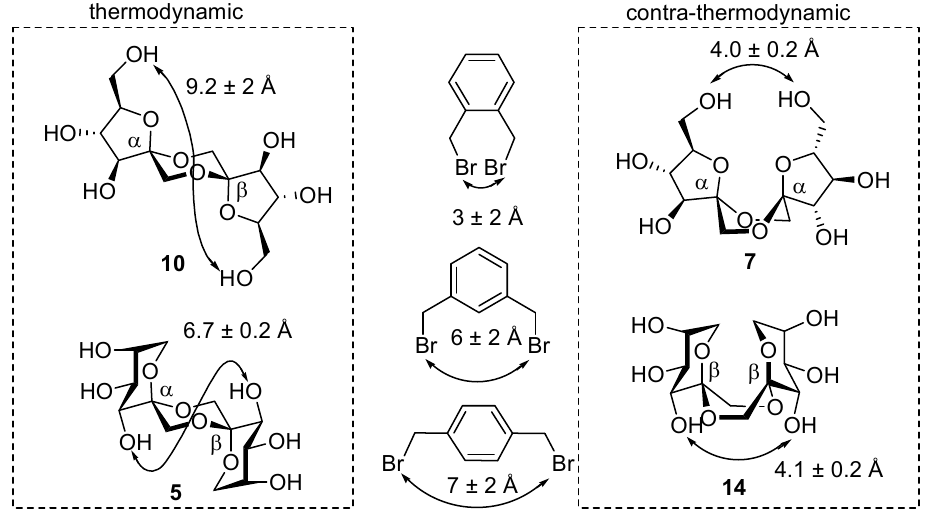
Figure 11 . Preferred conformations of type I and type III DFAs positional isomers, with indication of the O-6 − O-6', O-3 − O-3' interatomic distances, respectively. The